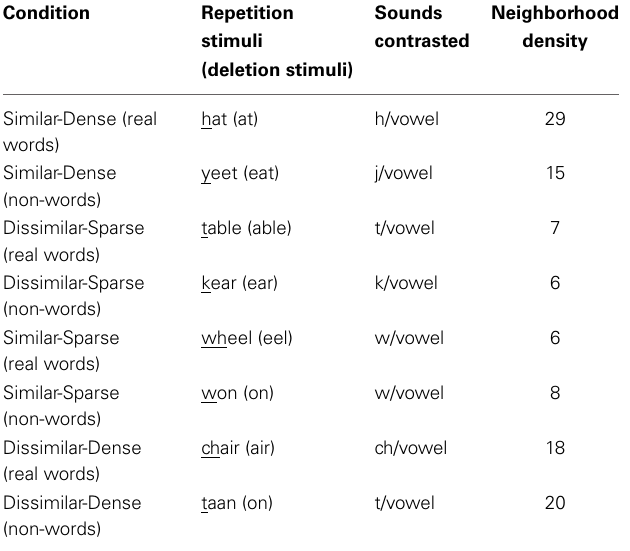
Table 2 | Real word and non-word sample stimuli for the Hogan Deletion Task.